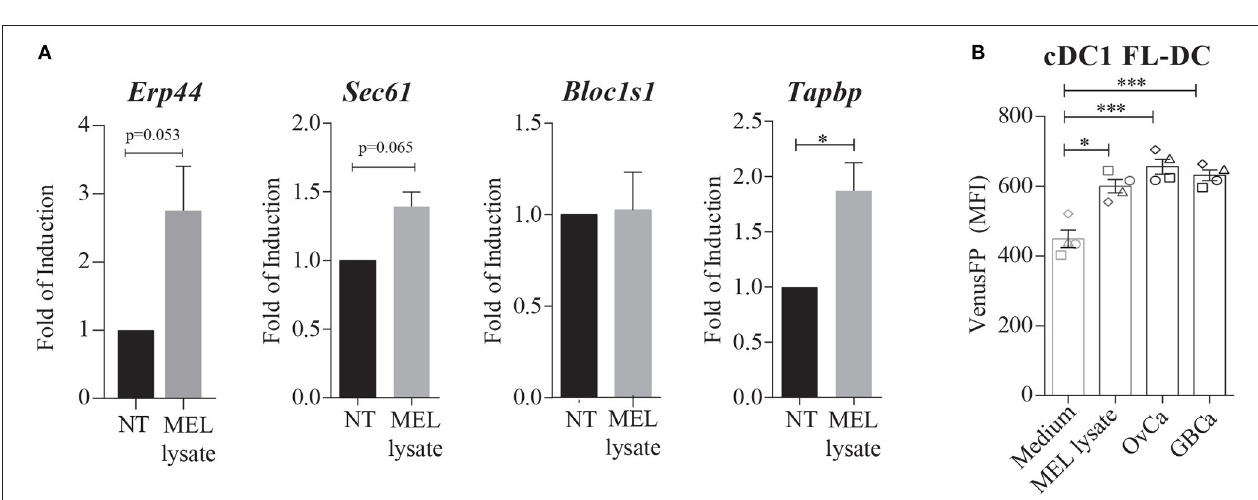
FIGURE 2 | Melanoma cell lysates induce activation of XBP1s and XBP1s-dependent genes, but not RIDD. (A) FL-DCs were left untreated (NT) or were stimulated with 100 µ g/ml MEL for 8h. Expression of Erp44, Sec61a , Bloc1s1 , and Tapbp mRNA was measured by qPCR relative to L27 expression, and depicted as fold of induction to the NT condition. Data in graphs depicts three to five independent experiments. (B) Expression of VenusFP in FL-DCs generated from ERAI mice and stimulated with AIM-V medium (control medium) 100 ug/ml MEL, 100 ug/ml human ovarian cancer lysate (OvCa) and 100 ug/ml human gallbladder cancer cells lines (GBCa) for 24h. Data in graphs depicts the MFI of cDC1 FL-DCs (XCR1 + ) and each symbol in the graph represents data derived from one independent experiment. For all error bars represent mean ± SEM. * p < 0.05, *** p < 0.001 (paired Student’s t